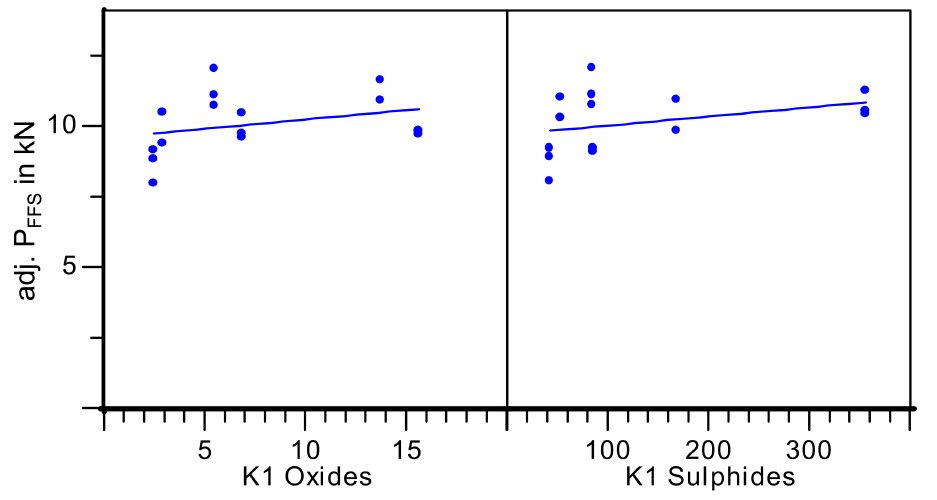
Figure 15. Fast fracture load P FFS as a function of the degree of